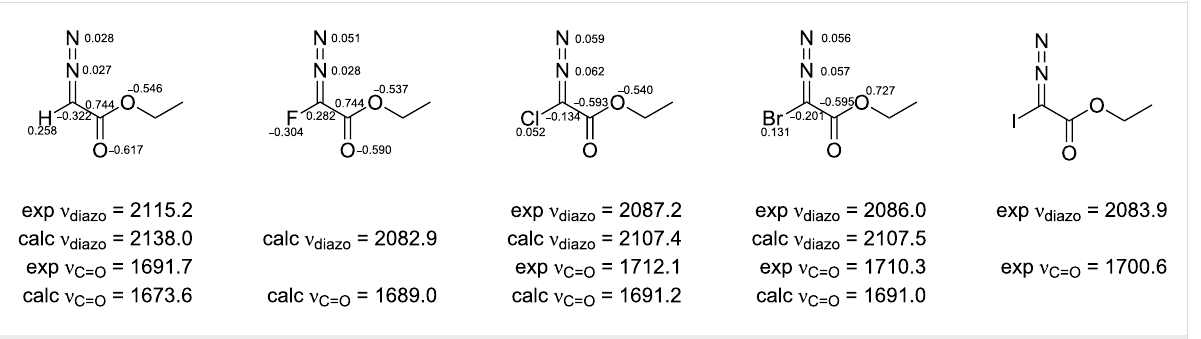
Figure 5: NBO atomic charges and IR stretching frequencies calculated [21] and experimentally recorded for 1 and 2a – c